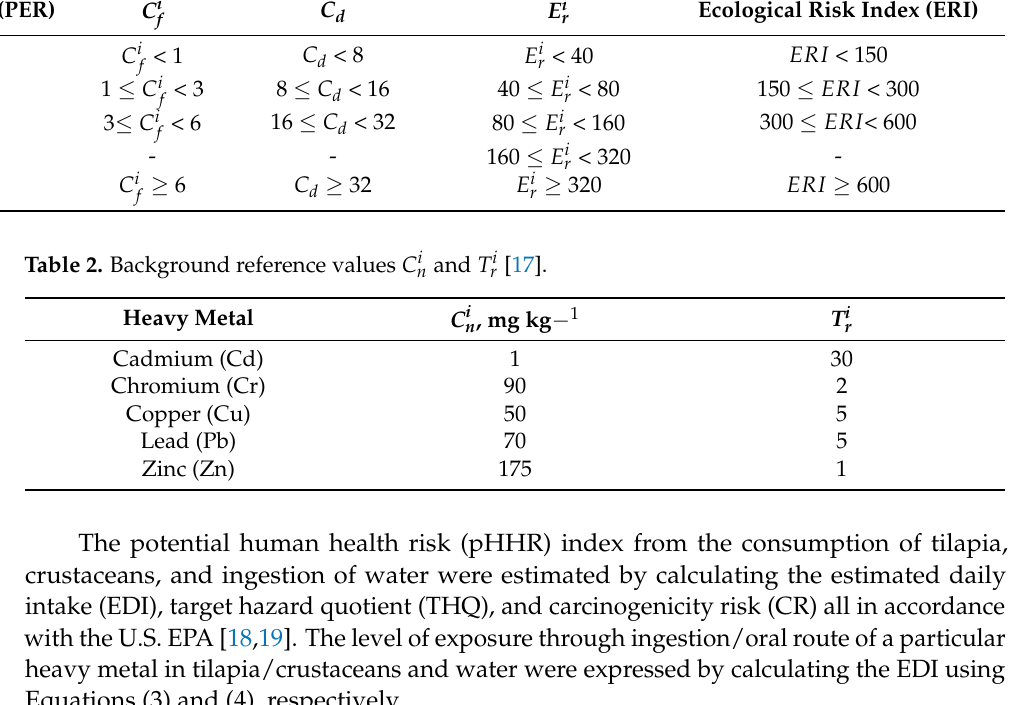
Table 1. Gradation (critical) range for contamination factor, degree of contamination, risk coefficient, and index [17]. Potential Ecological Risks (PER)